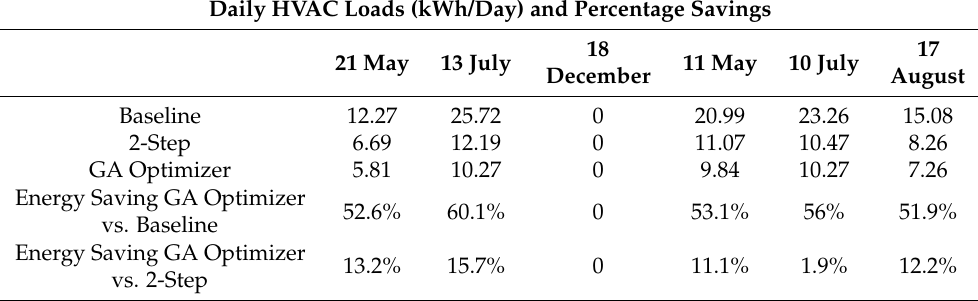
Table 6. HVAC loads for baseline windows and STIS–smart windows applied to a house located in San Francisco, CA, USA for six representative days using two control strategies.